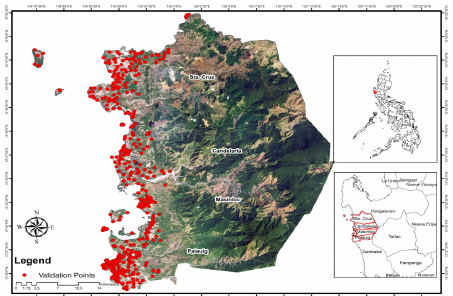
Figure 8. Validation points of the study